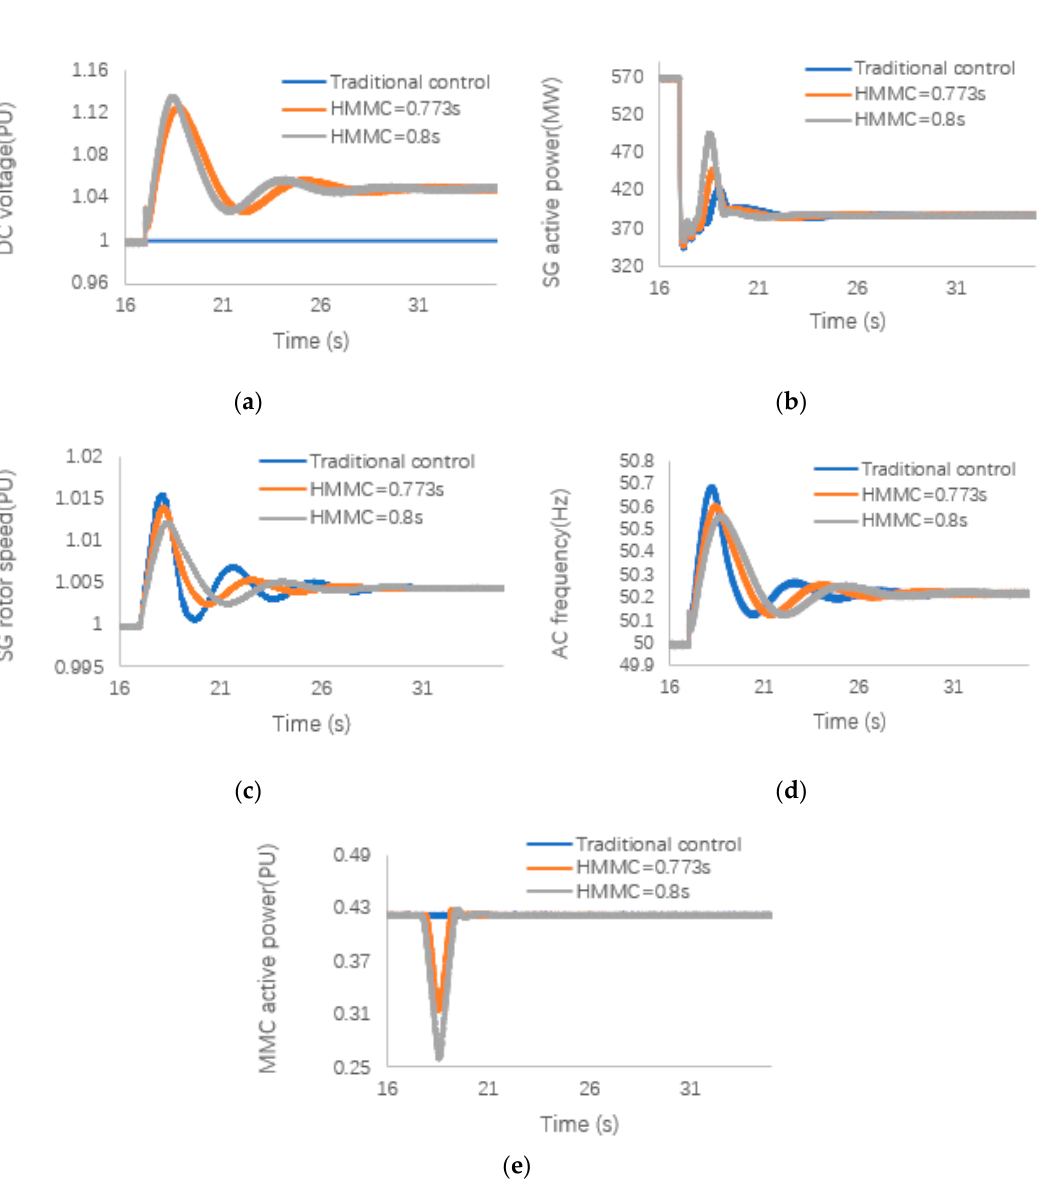
Figure 9. ESCR is 2.5 for 20% load decrease: ( a ) DC voltage; ( b ) SG active power; ( c ) SG rotor speed; ( d ) AC system frequency; ( e ) MMC active power.